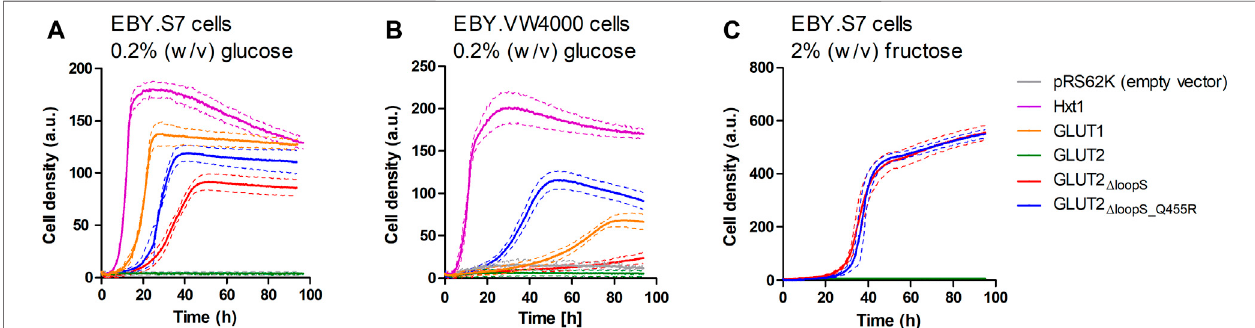
FIGURE 3 | Growth of hxt 0 cells expressing GLUT2 variants on hexoses. Cell growth of EBY.S7 (A,C) or EBY.VW4000 (B) cells containing the empty pRS62K vector, the endogenous Hxt1 transporter (only (A) , (B) ), GLUT1 (only (A) , (B) ), GLUT2, GLUT2 Δ loopS or GLUT2 Δ loopS_Q455R , was recorded with the Cell Growth Quanti fi er (AquilaBiolabs). The YEP medium wassupplemented with 200 μ g/ml G418 for plasmid selection and 0.2% (w/v) glucose (A,B) or 2% (w/v) fructose (C) . The average of three biological replicates (continuous lines) and the error (dashed lines) are shown. Apparent maximal growth rates for the growing cells were calculated with the CGQuant software and are listed together with the duration of lag phases in Supplementary Table S5